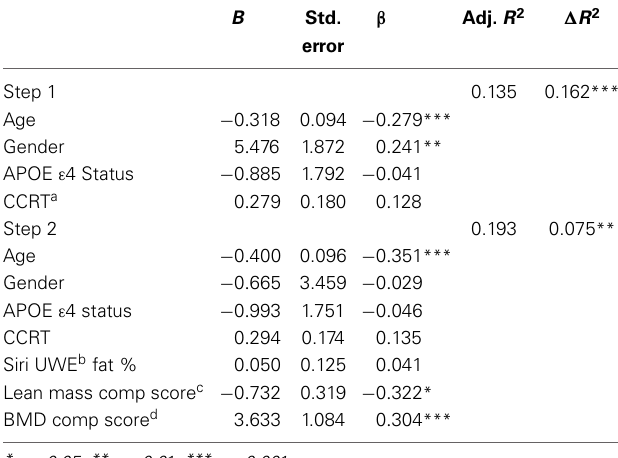
Table 6 | Hierarchical linear regression predicting follow up CVLT List A trials 1–5 total score from lean mass and bone density composite